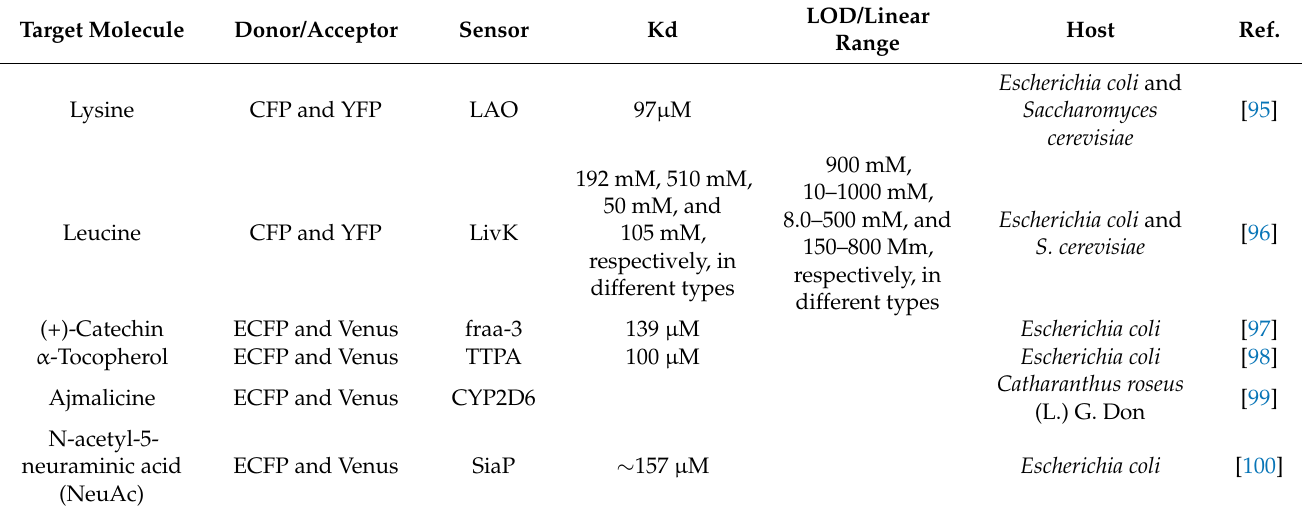
Table 4. Recently developed FRET- and BRET-based whole-cell sensors for dynamic analysis of metabolic flux.